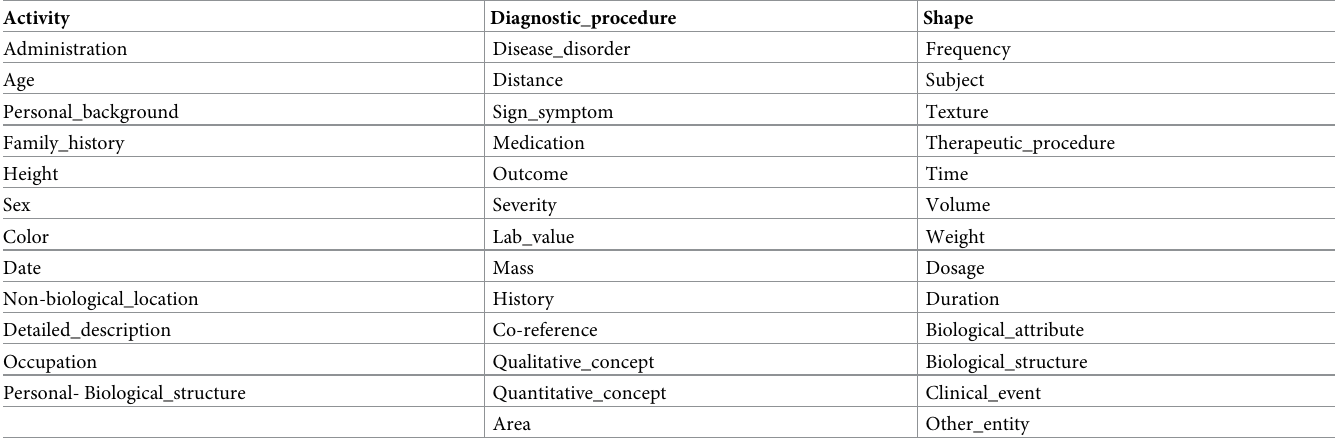
Table 1. Named entities used in this